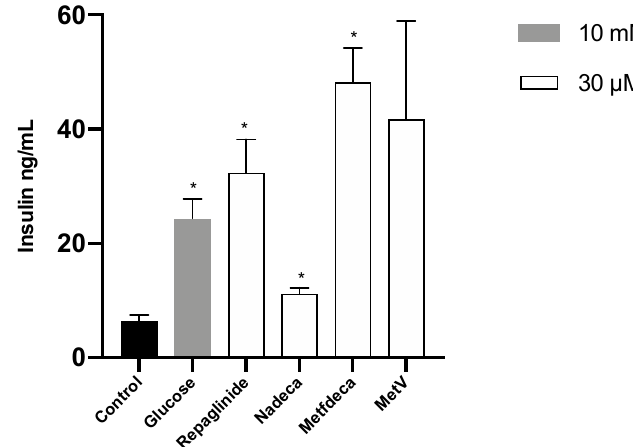
Figure 7. E ff ect of the vanadium compounds (30 µ M concentration) on the insulin release in β TC-6 cells with 10 mM of glucose and 30 µ M of repaglinide. All the values are the mean ± SD. * p < 0.05 vs. untreated control